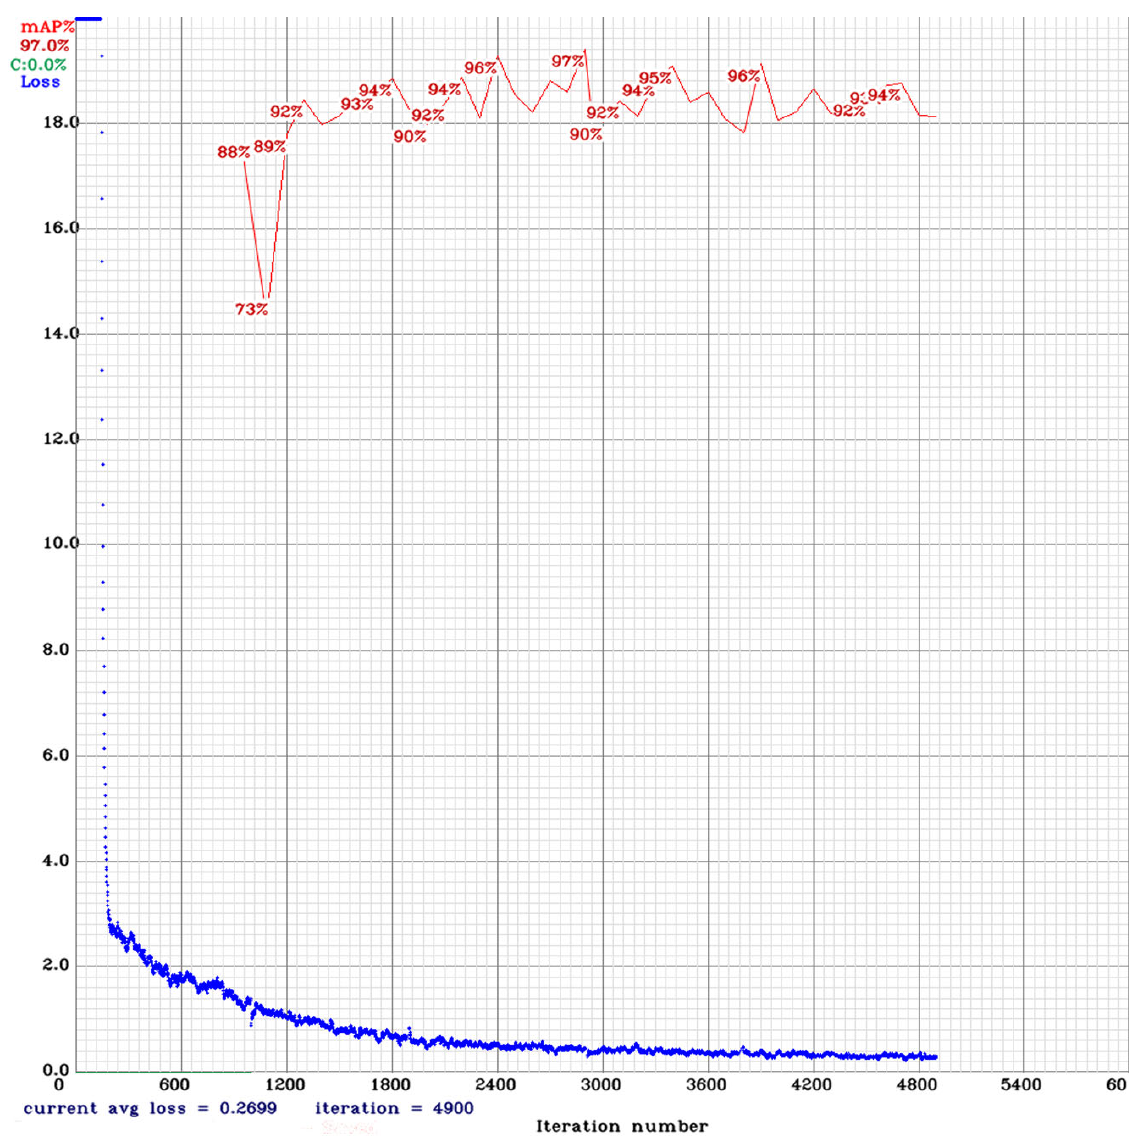
Figure 3. The results of the YOLOv4 training. The red line—mean Average Precision ( mAP ). The blue line–error graph (Loss). Table 2. The density distribution of all BC images included to the test